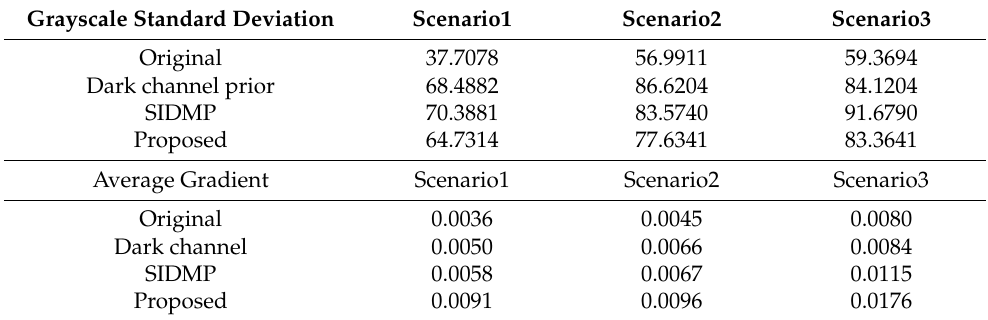
Table 1. Quantitative evaluation of defogging algorithms in the three scenes shown in Figure 7.